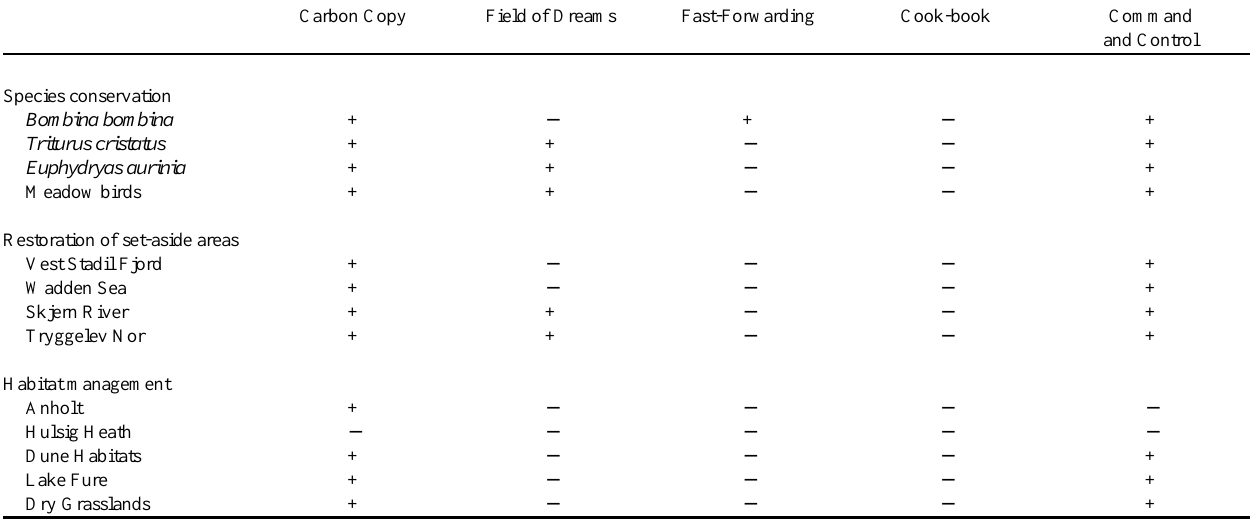
Table 3 . Evaluation of the 13 analyzed projects by use of the five myths of restoration ecology by Hilderbrand et al. (2005). Presence of the myths is indicated with (+), whereas ( - ) indicates that the myths have not been